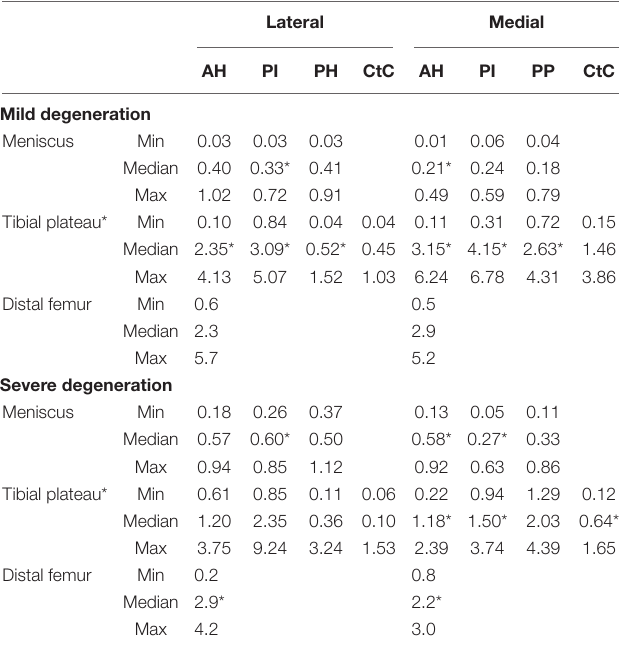
TABLE 4 | Maximum applied load, P max (minimum, median, and maximum values), of the cartilaginous (femur and tibia) and meniscus (AH, PI, PH, and CtC area) surface localizations.